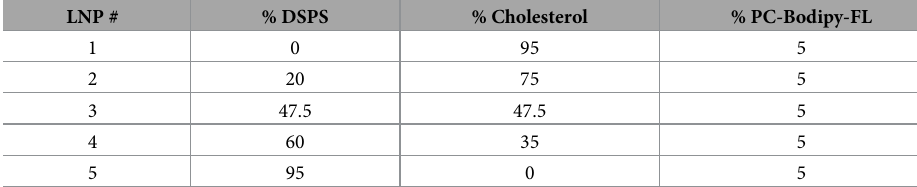
Table 1. Lipid composition of LNP used in this study.